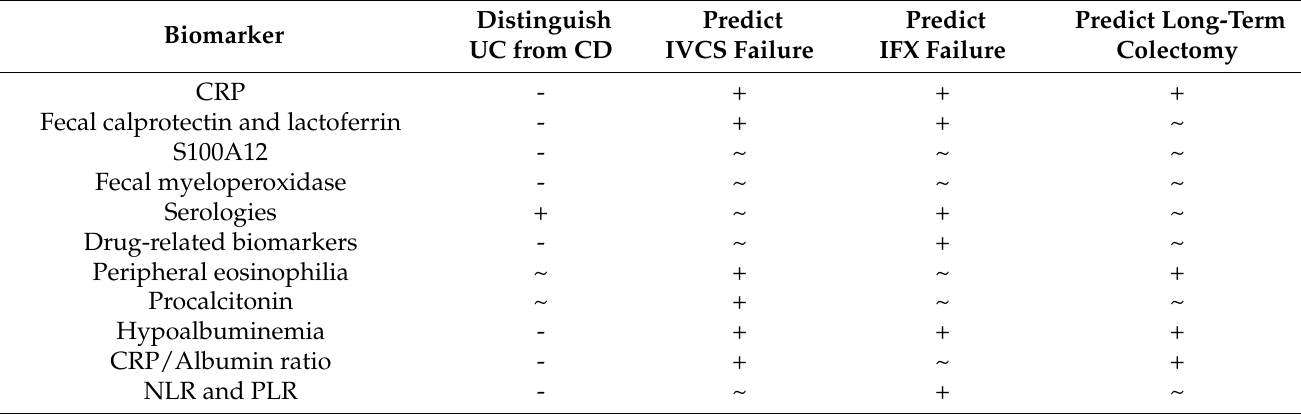
Table 2. Biomarkers associated with UC and their utility in various areas.